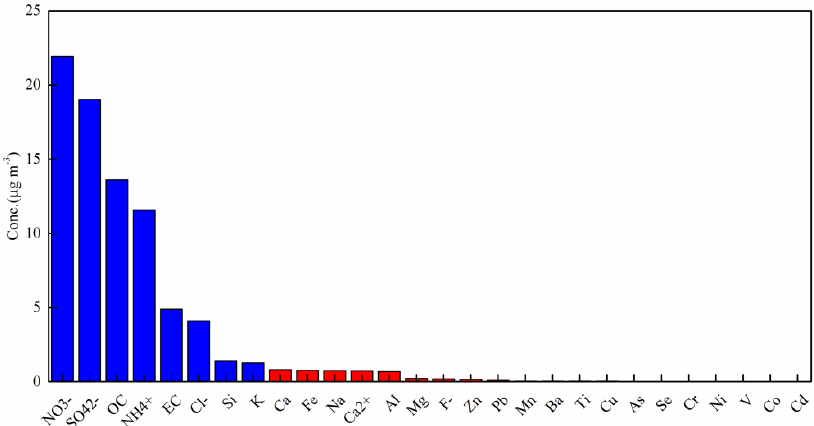
Figure 3. Average concentrations of chemical components in PM 2.5 (data shown in blue are the primary component > 1.0 µ g m − 3 , while data shown in red are < 1.0 µ g m − 3 ).